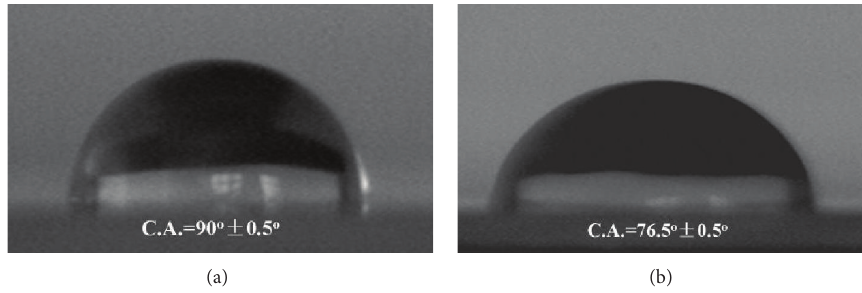
Figure 6: Contact angle obtained from ZnO thin films grown on a-plane and c-plane